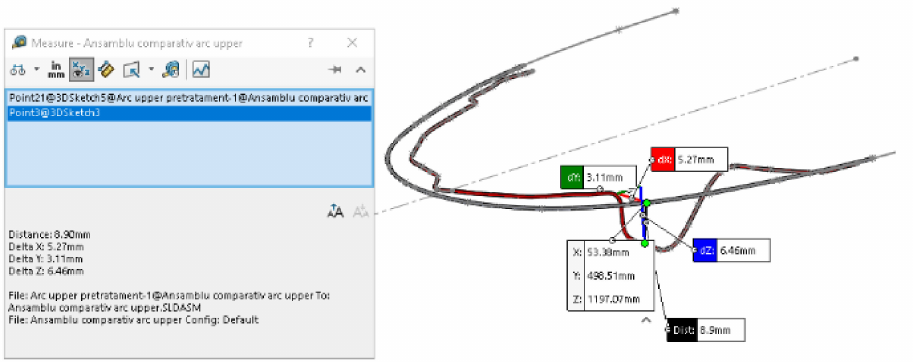
Figure 26. Measurement of the x deformation for 1.3.